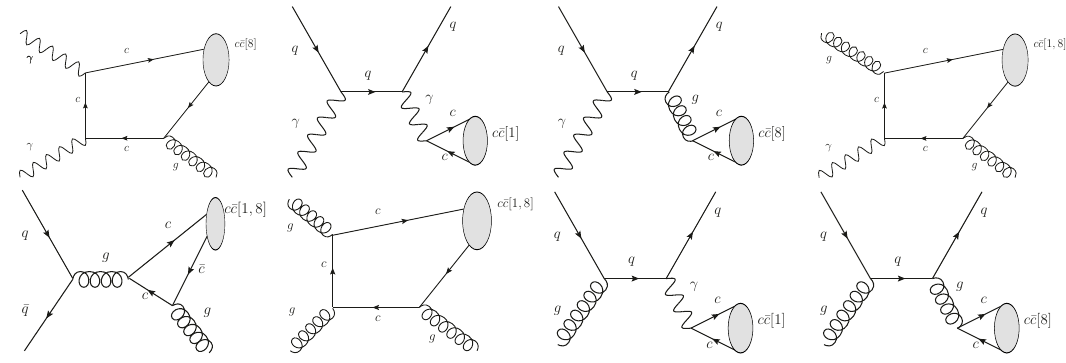
Figure 2 . Some Feynman diagrams of the photoproduction. The diagrams are drawn by Jaxo- Draw